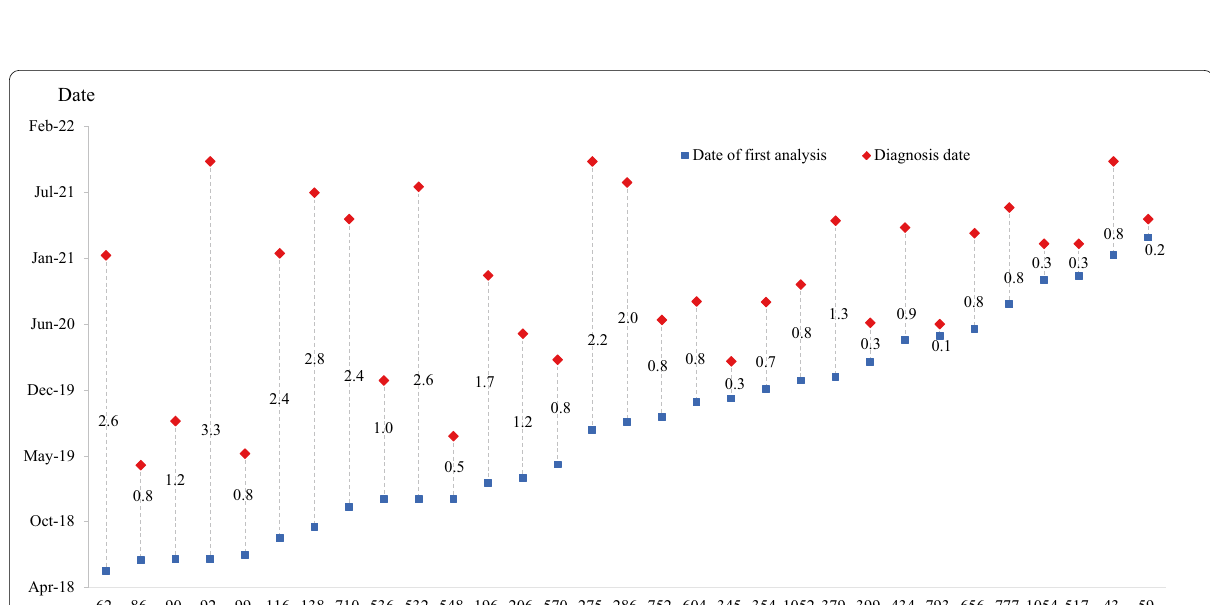
Fig. 4 The number of patients with newly reclassified variants (red line) and the number of newly reclassified variants (blue line) based on daily reanalysis data from April 2019 to October 2021